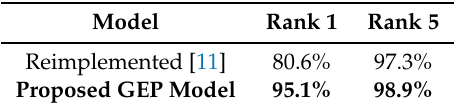
Table 6. Comparison of reimplemented [11] and the proposed